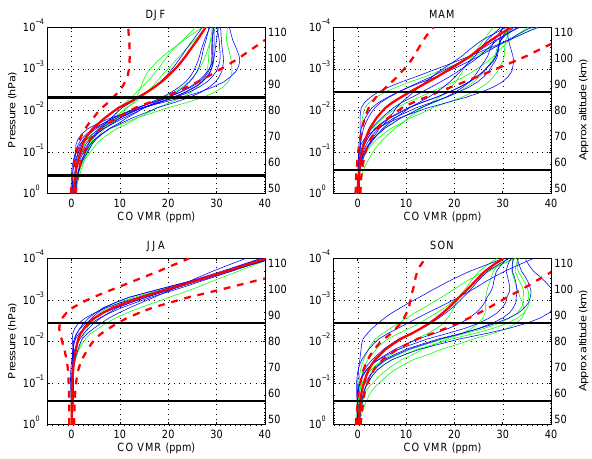
Fig. 3. Retrieved profiles 2002–2008 (every 20th profile is plotted for each season). CO volume mixing ratios are plotted against pres- sure (and altitude). The red line shows the average a priori profile for the season, and the dashed line the standard deviation of the a priori profile. Green lines are retrieved profiles 2002–2004 and the blue lines are profiles 2004–2008. The mean measurement response of the OSO instrument is higher than 0.8 between the black horizontal